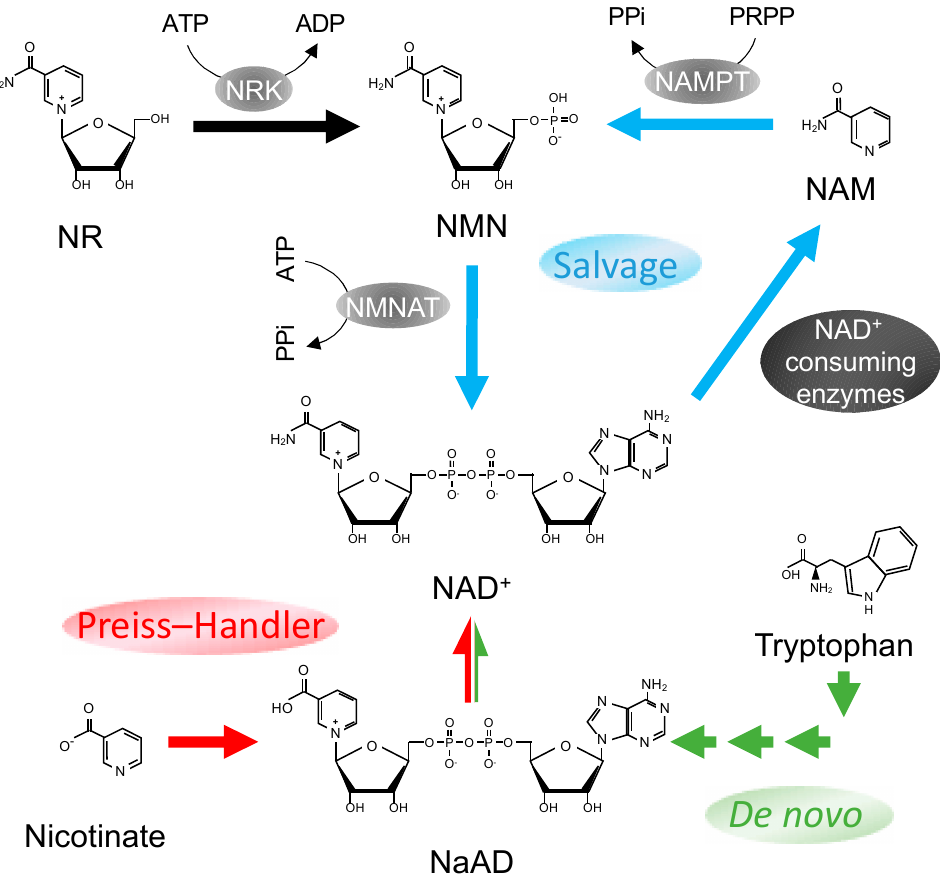
Figure 1. Nicotinamide adenine dinucleotide (NAD + ) biosynthesis pathways in mammals. Three pathways for NAD + synthesis in mammalian cells: NAD + salvage pathway (blue), Preiss–Handler pathway (red), and de novo pathway (green). NaAD, nicotinic acid adenine dinucleotide; NAM, nicotinamide; NAMPT, nicotinamide phosphoribosyltransferase; NMN, nicotinamide mononucleotide; NMNAT, nicotinamide/nicotinic acid mononucleotide adenylyltransferase, NR, nicotinamide riboside; NRK, nicotinamide riboside kinase; PRPP, 5-phosphoribosyl 1-pyrophosphate; PPi,